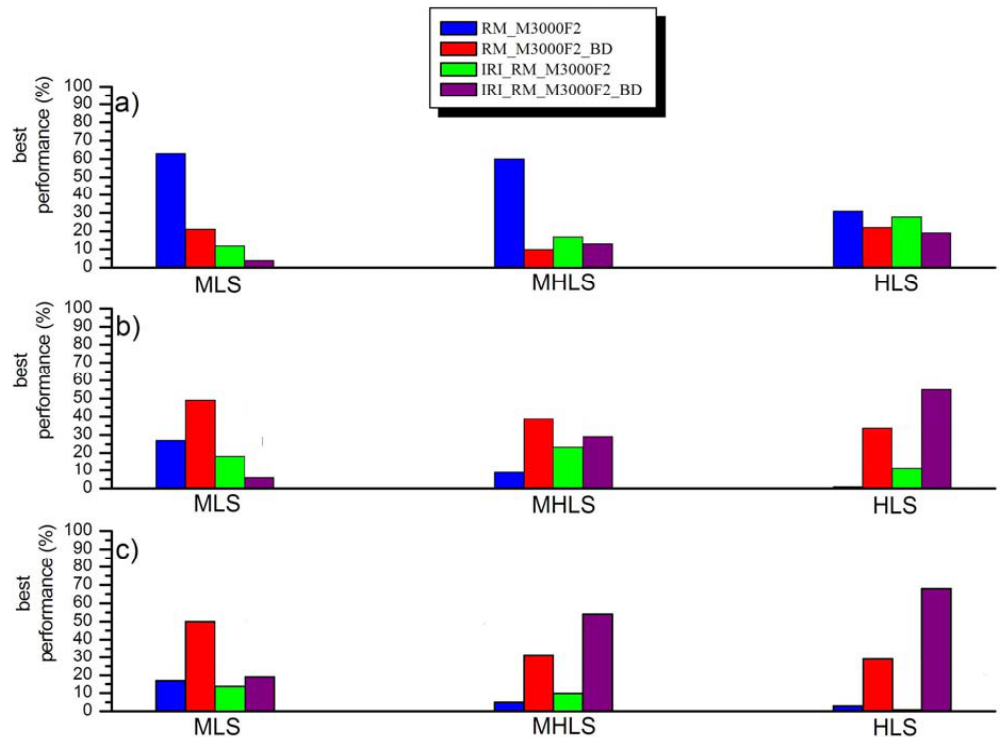
Fig. 4. The percentages of the best performances offered by RM_M3000F2 , RM_M3000F2_BD , IRI_RM_M3000F2, and IRI_RM_M3000F2_BD deduced from Tables 2–5 are shown in blue, red, green, and purple respectively in the case of (a) moderate, (b) dis- turbed, and (c) very disturbed geomagnetic activity for MLS, MHLS, and HLS.